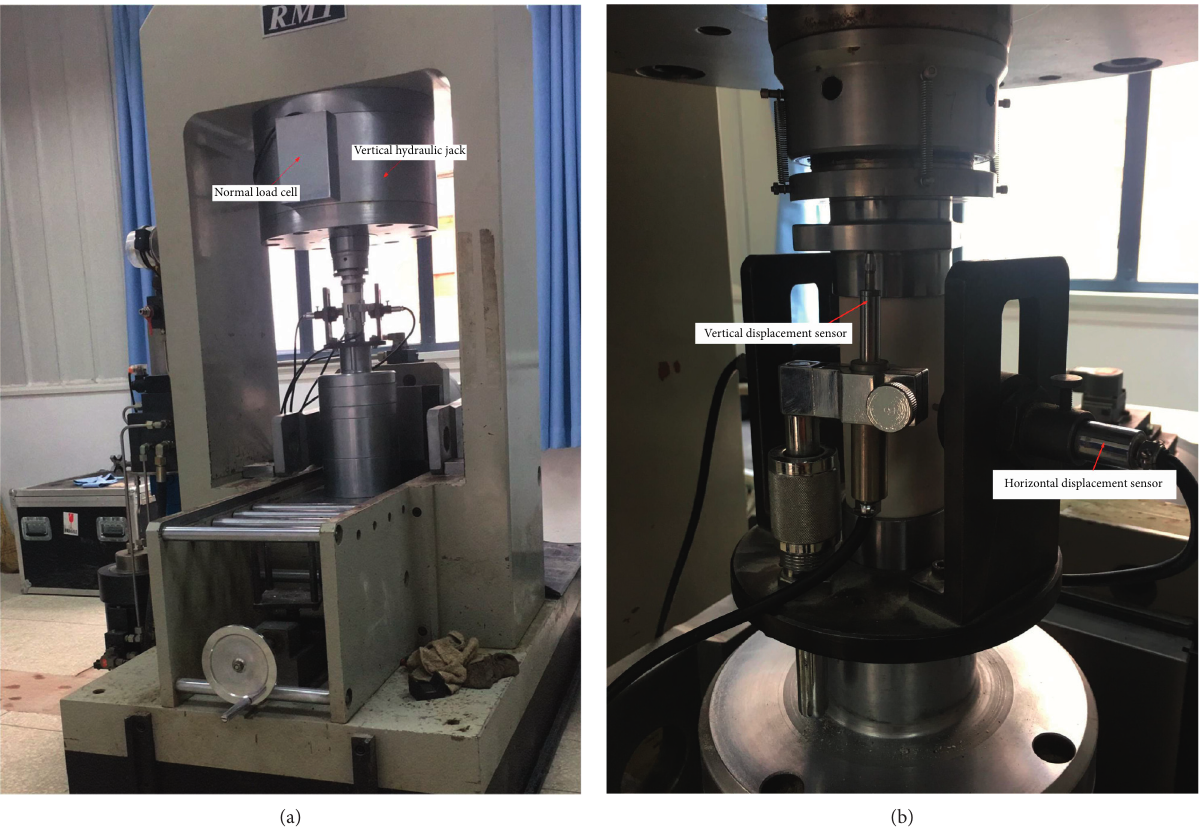
Figure 3: RMT-301 mechanical test system for rock and concrete. (a) Front view of the RMT-301 servohydraulic test equipment. (b) Close- up view of the RMT-301 servohydraulic test